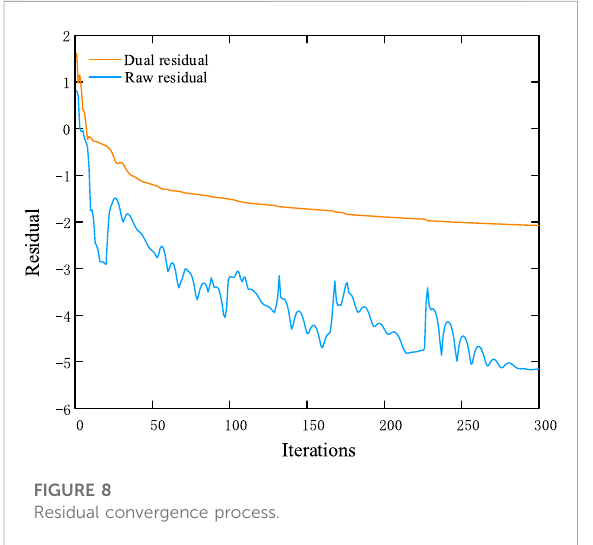
FIGURE 8 Residual convergence process.